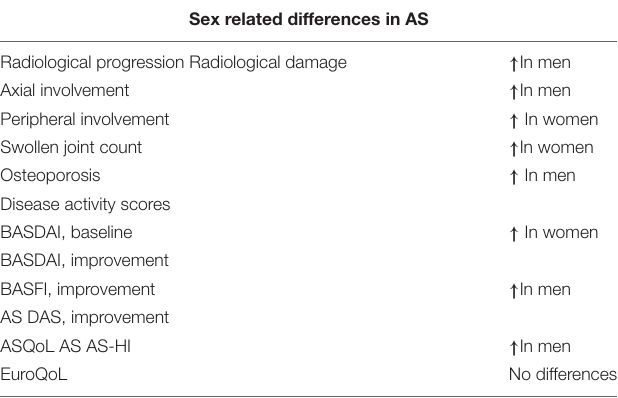
TABLE 2 | Clinical differences related to gender in Ankylosing Spondylitis. Sex related differences in